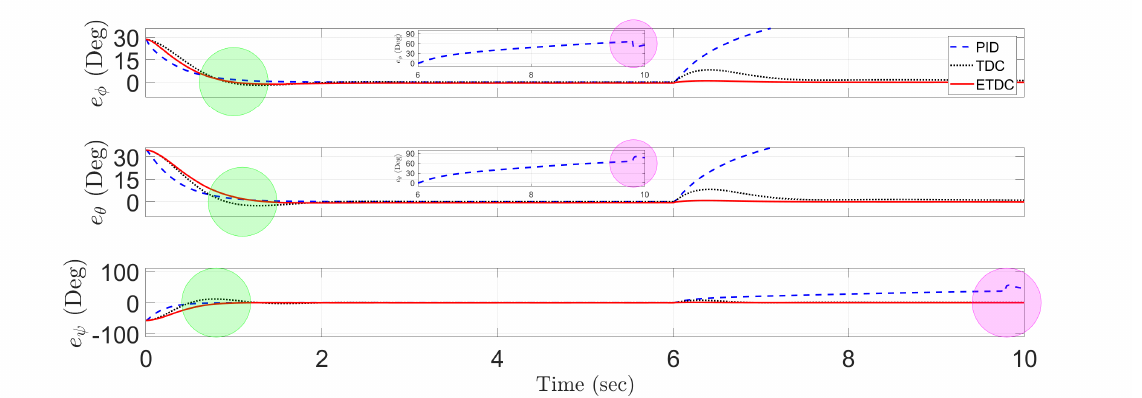
Figure 6. Comparison of the trajectory-tracking errors of PID control scheme (dotted line), conventional TDC scheme (dashed line), and the proposed ETDC scheme (solid line): with ED (one direction) (C2) and